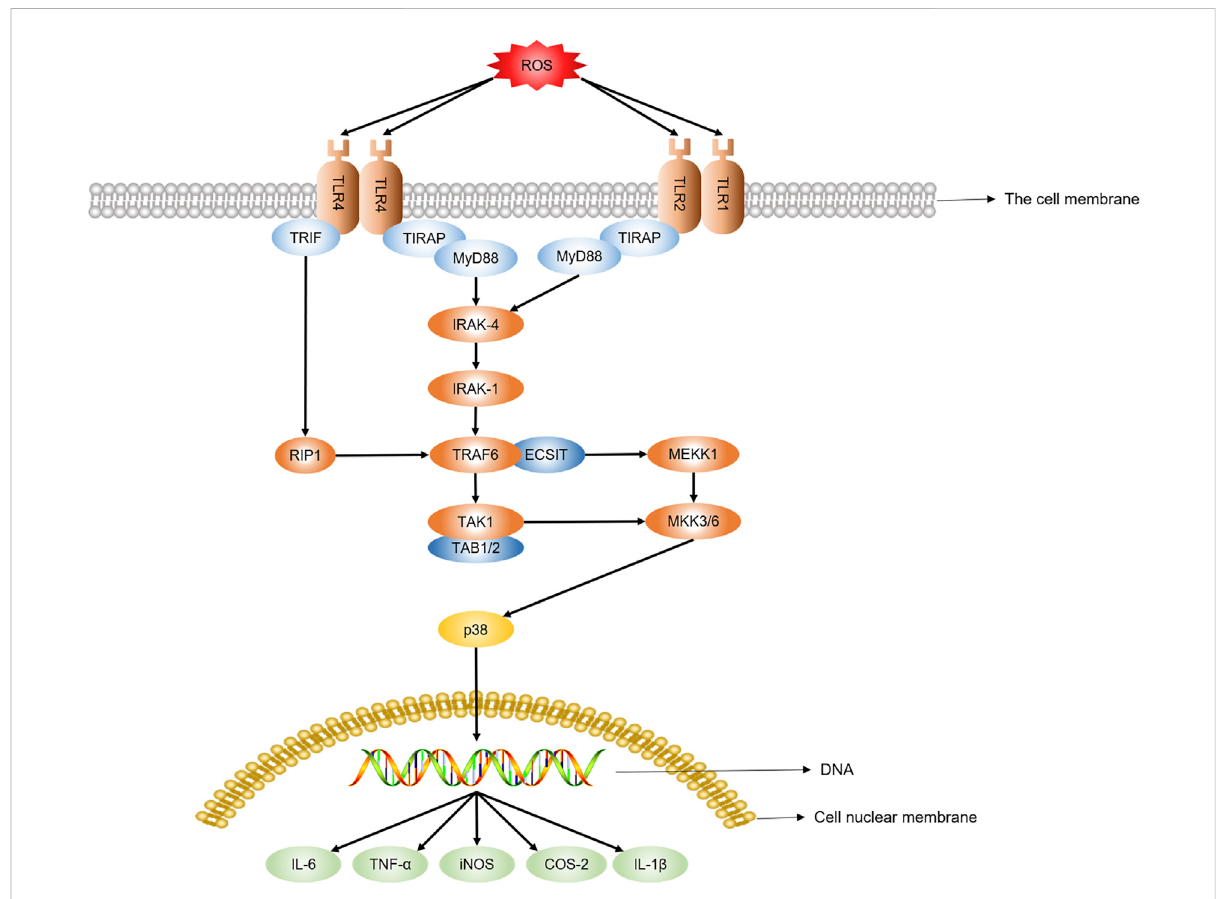
FIGURE 2 ROS promote pro-in fl ammatory factors release through the NF-KB